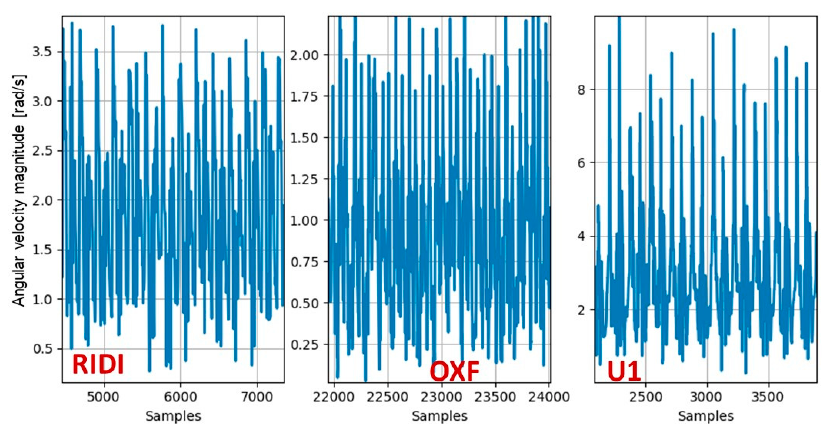
Figure 9. The final dataset’s (comprising of the eight di ff erent datasets) sample distribution to each of the possible smartphone locations.